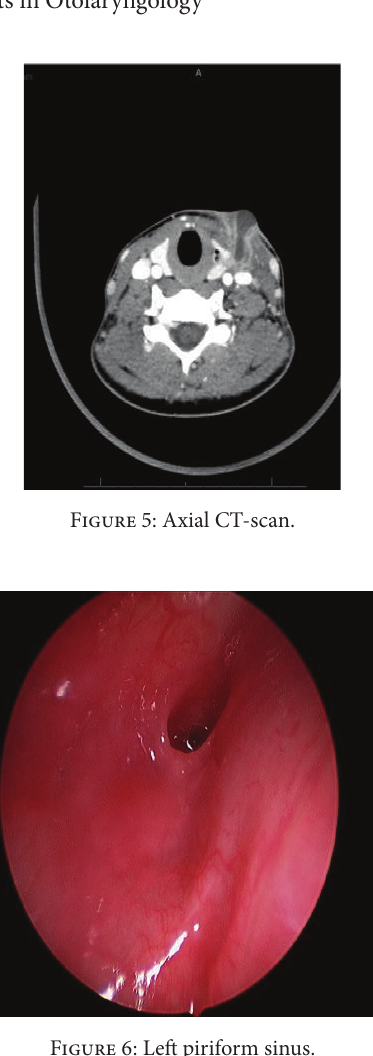
Figure 6: Left piriform sinus.